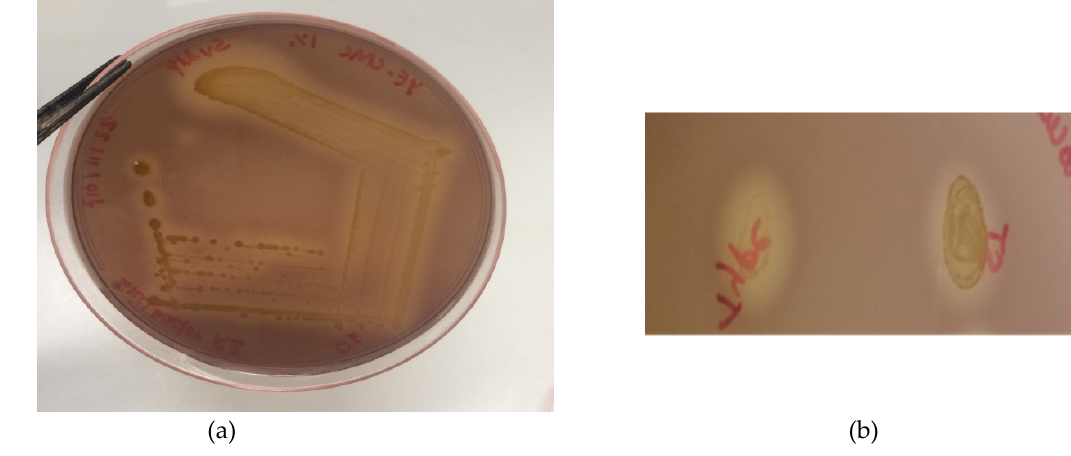
Figure 3. Cellulase activity assay in carboxymethyl cellulose (CMC) plates after Gram’s Iodine treatment. ( a ) zone of CMC clearance after streaking plating the #493 isolate. ( b ) similarity in cellulase activity between the S. turicensis Type strain (left) and isolate #493 (right).